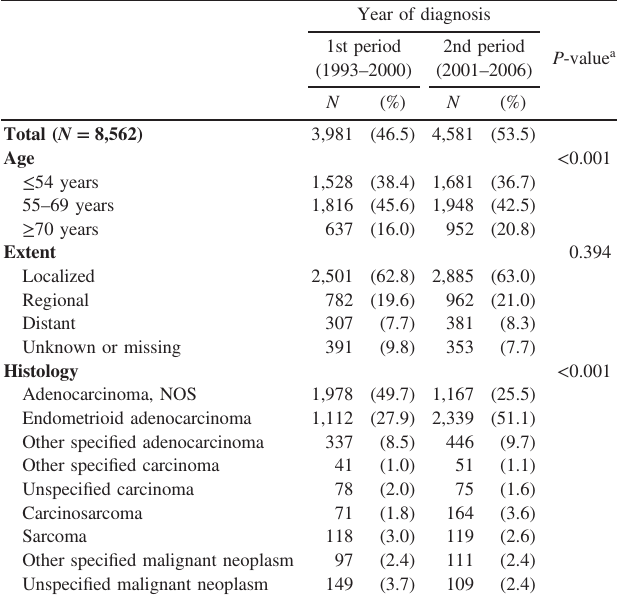
Table 1. Characteristics of study subjects